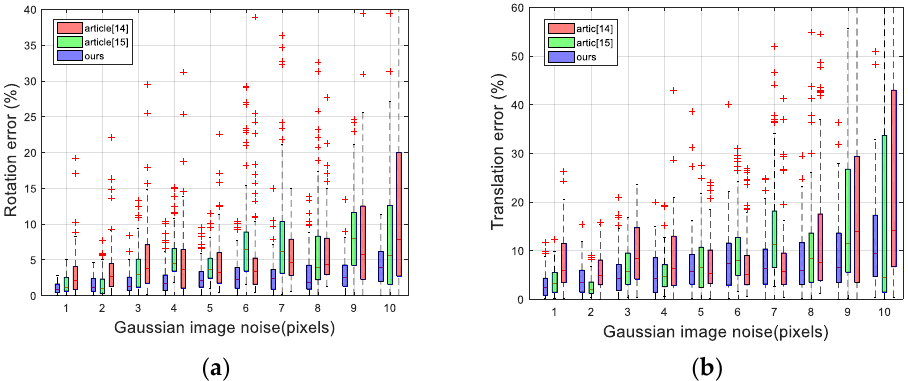
Figure 3. Pose estimation errors for different noise. ( a ) Rotation matrix error ( b ) Translation vector error.